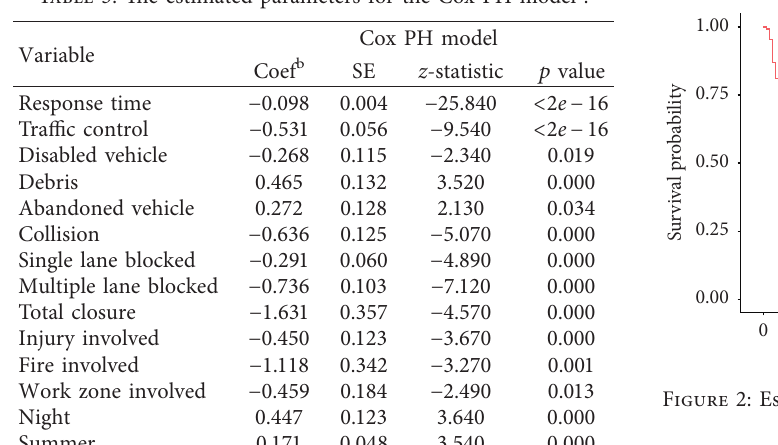
Table 3: The estimated parameters for the Cox PH model a .